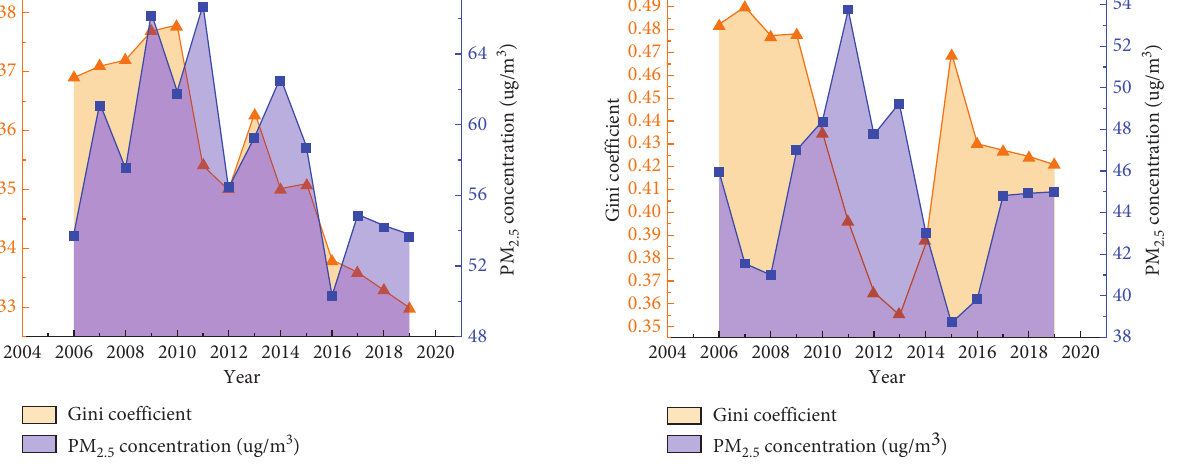
2.5 concentration of